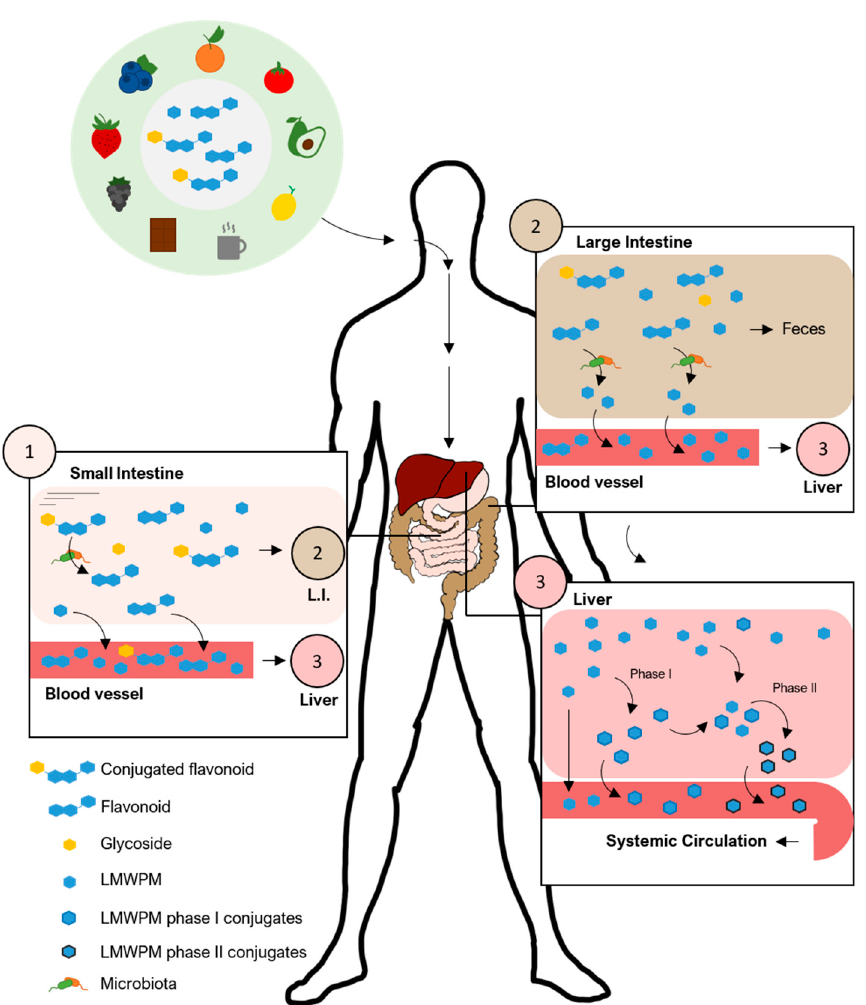
Figure 1. Diets rich in (poly)phenols originate large amounts of flavonoids and flavonoid conjugates reaching the digestive system. (1) In the small intestine, epithelial and bacterial enzymes remove sugar conjugates while absorption occurs. (2) The majority of flavonoids travel to the lower part of the gut where microbiota catabolizes flavonoids into LMWPM that will be absorbed into enterohepatic circulation. (3) LMWPM will enter systemic circulation intact or will undergo phase I and II metabolic reactions by intestinal and liver cells before reaching the circulation. LMWPM—low molecular weight (poly)phenol metabolites. L.I.—large intestine.